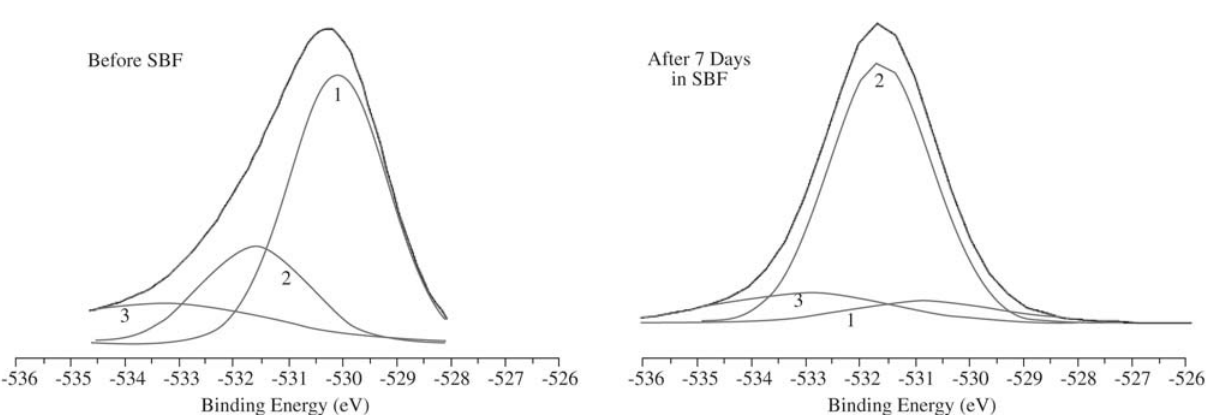
Figure 6 . Anodized titanium sheet before and after immersion for 7 days into SBF around. XPS spectra around O 1s region. 1) O 2- ; 2) OH - or PO 43- ; 3) adsorbed water.